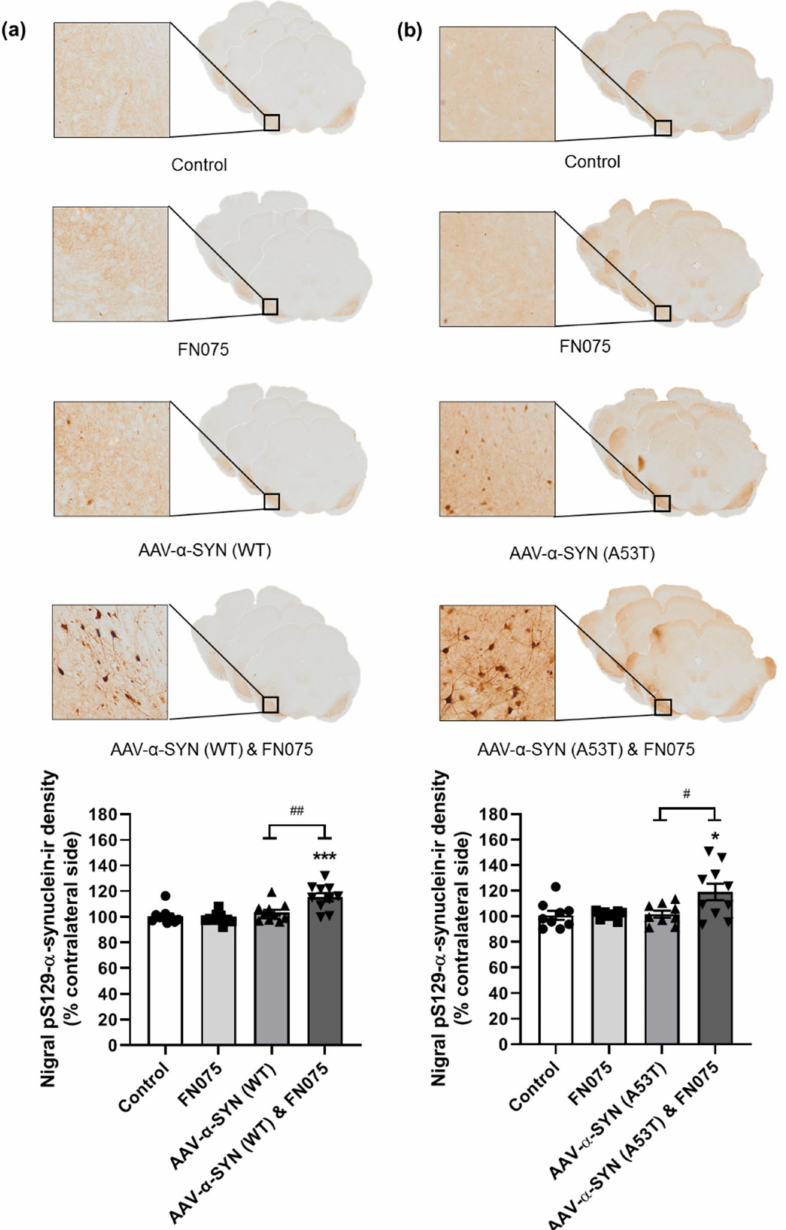
Figure 3. Immunohistological assessment of the impact of FN075 on the phosphorylation of α - synuclein at serine 129 in the substantia nigra. FN075 in combination with ( a ) AAV- α -SYN (WT) or ( b ) AAV- α -SYN (A53T) induced a significant increase in the density of pS129- α -synuclein in the substantia nigra. Data are represented as mean ± SEM with n = 8–10 animals per group. * p < 0.05, *** p < 0.001 vs. Control; # p < 0.05, ## p < 0.01 vs. corresponding AAV- α -synuclein group by one-way ANOVA with post hoc